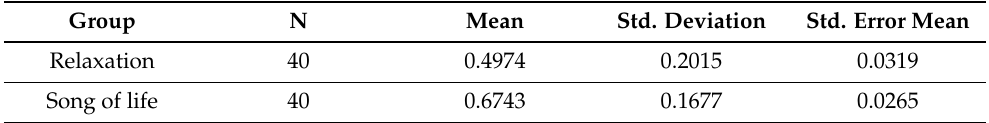
Table 8. Variance analysis result of satisfaction for both